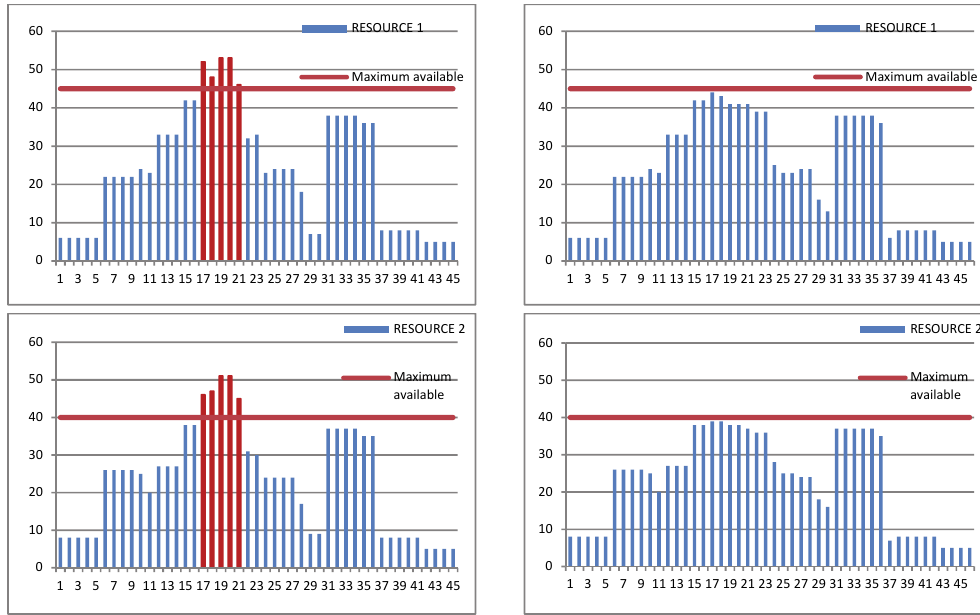
Fig. 8. Daily usage of the resources before and after using the proposed method throughout the calendar of the project